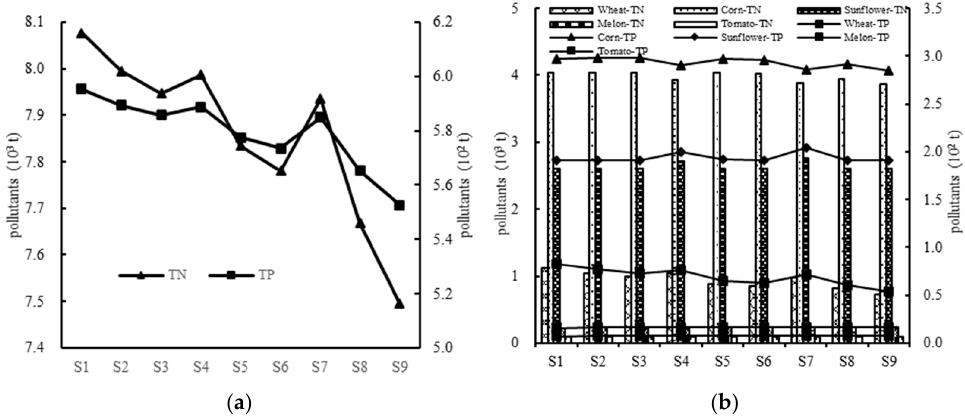
Figure 7. The agricultural TN and TP pollution exports in Bayan Nur City in nine scenarios. ( a ) Over agriculture. ( b ) Each crop.